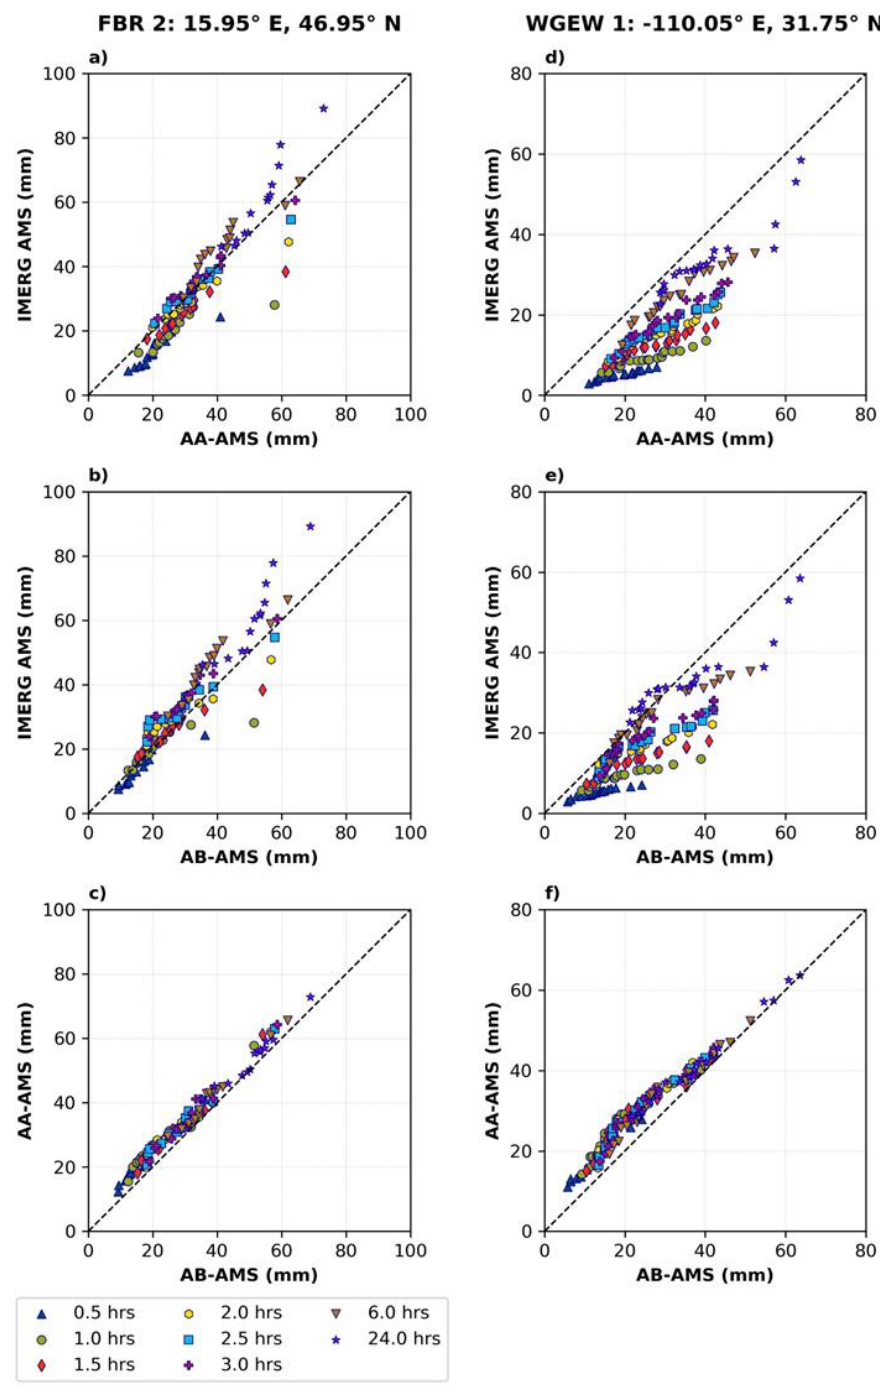
Figure 5. QQ-plots comparing the AMSs for FBR 2 ( left ) and WGEW 1 ( right ). From top to bottom: IMERG AMS vs. AA-AMS, IMERG AMS vs. AB-AMS, and AA-AMS vs. AB-AMS. The markers are the durations 0.5, 1, 1.5, 2, 2.5, 3, 6, and 24 h. The 45° dashed line is a reference line.